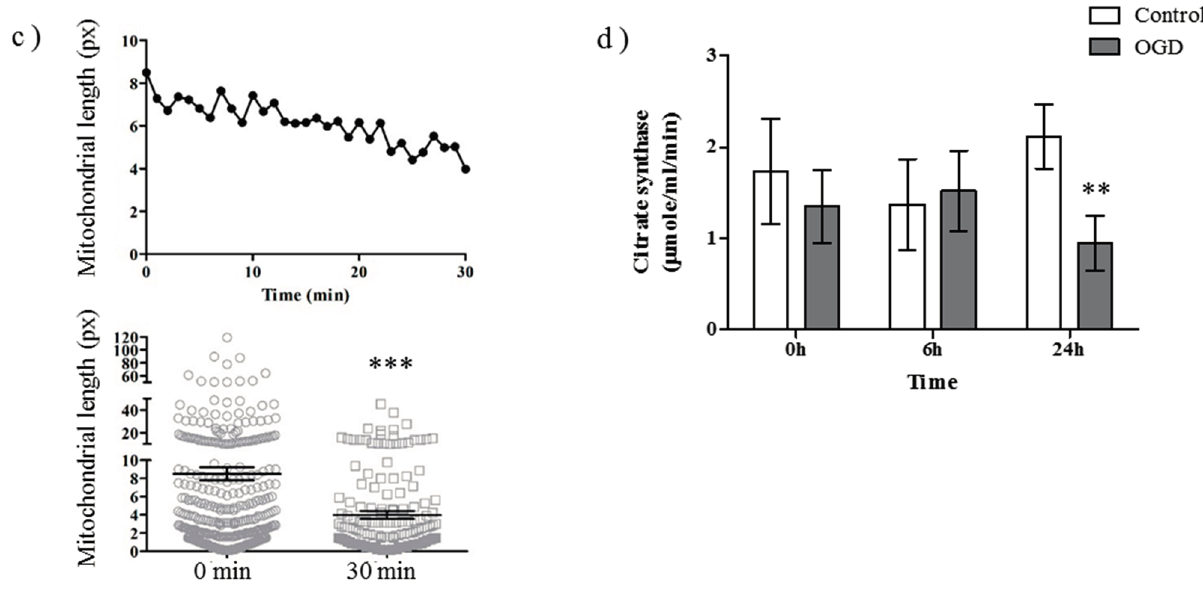
Figure 1. Oxygen-glucose deprivation (OGD) alters mitochondrial membrane potential, morphology and function in primary cortical neurons. ( a ) Primary mouse cortical neurons were loaded with JC-1 dye and Hoechst before exposure to OGD. Cells were imaged live before (Con) and at 15, 45 and 90 min during OGD. Both mitochondrial morphology (as observed in red, top row) and membrane potential (increased green signal, second row) are altered during exposure to OGD. Scale bar represents 100 µm; Figures are representative of three individual experiments: ( b ) Enlargement (3×) of regions defined by white boxes in ( a ). As the experiment progresses, mitochondria morphology appears to alter from tubular structures to round punctate or larger aggregations; ( c ) Primary neurons loaded with JC-1 were imaged every minute during OGD followed by analyses of mitochondrial